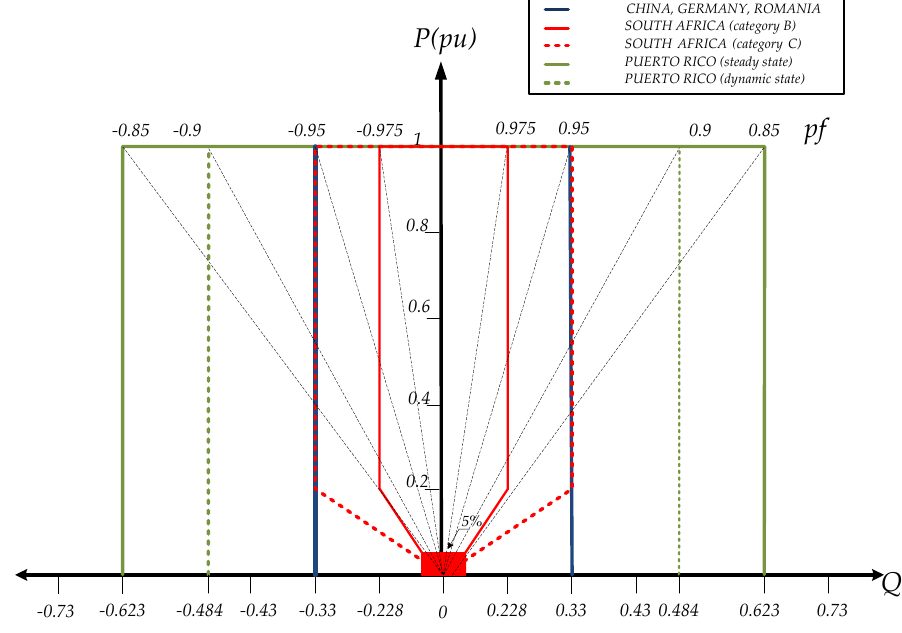
Figure 2. Reactive power